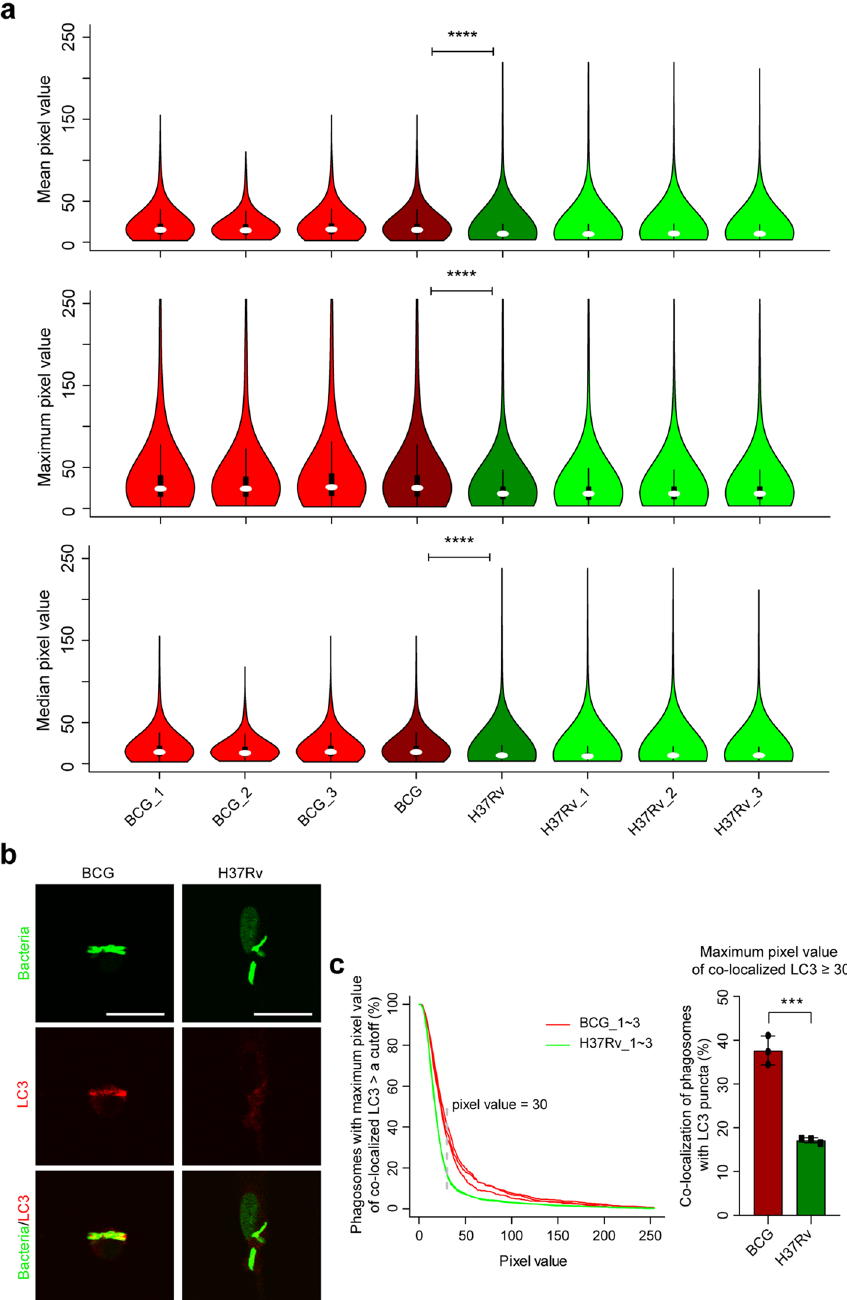
Figure 4. Co-localization of LC3 with intracellular M. bovis BCG or Mtb H37Rv in BMDMs. ( a ) Violin plots of mean (upper panel), maximum (middle panel), or median (lower panel) PVs of LC3 co-localized with intracellular mycobacteria/phagosomes. BCG_1–3: individual violin plot of PVs from three coverslips from separate experiments; BCG: violin plot of combined PVs BCG_1–3. H37Rv_1–3 and H37Rv indicates corresponding data obtained with H37Rv. There were at least 300 phagosomes/PVs for each violin plot. ( b ) Representative images depicting the co-localization of intracellular mycobacteria/phagosomes with LC3 in BMDMs. Scale bars represent 10 μM. ( c ) Cumulative percentages of bacteria/phagosomes with a corresponding maximum PV of LC3 larger than a cutoff value (left panel) or ≥ 30 (right panel). *** P ≤ 0.001; **** P ≤ 0.0001; one-way ANOVA with Tukey’s multiple comparisons test for ( a ), or unpaired and two-tailed Student’s t test for ( c ) right